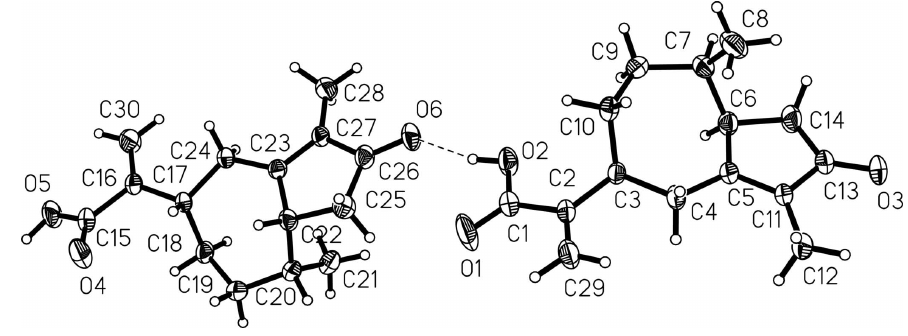
Figure 1 The content of asymmetric unit of (I) showing the atomic numbering and displacement ellipsoids drawn at the 30% probability level. Hydrogen bonds are shown as dashed